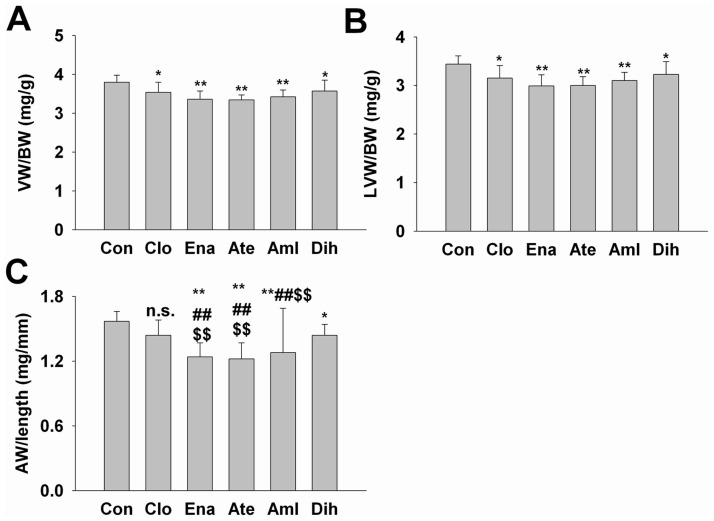
Effects of 3-month treatment of 5 different antihypertensive drugs on the end-organ damage of ventricle and aorta in SHR.(A), (B) and (C), Data are shown as mean ± SD. Data are analyzed by ANOVA followed by LSD post-hoc testing. *P < 0.05, **P < 0.01 vs. Con; ##P < 0.01 vs. Clo; $$P < 0.01 vs. Dih; n.s., not significant, n = 10. Abbreviation: VW, ventricular weight; BW, body weight; LVW, Left ventricular weight; AW, aortic weight; Clo, clonidine; Ena, enalapril; Ate, atenolol; Aml, amlodipine; Dih, dihydrochlorothiazide.